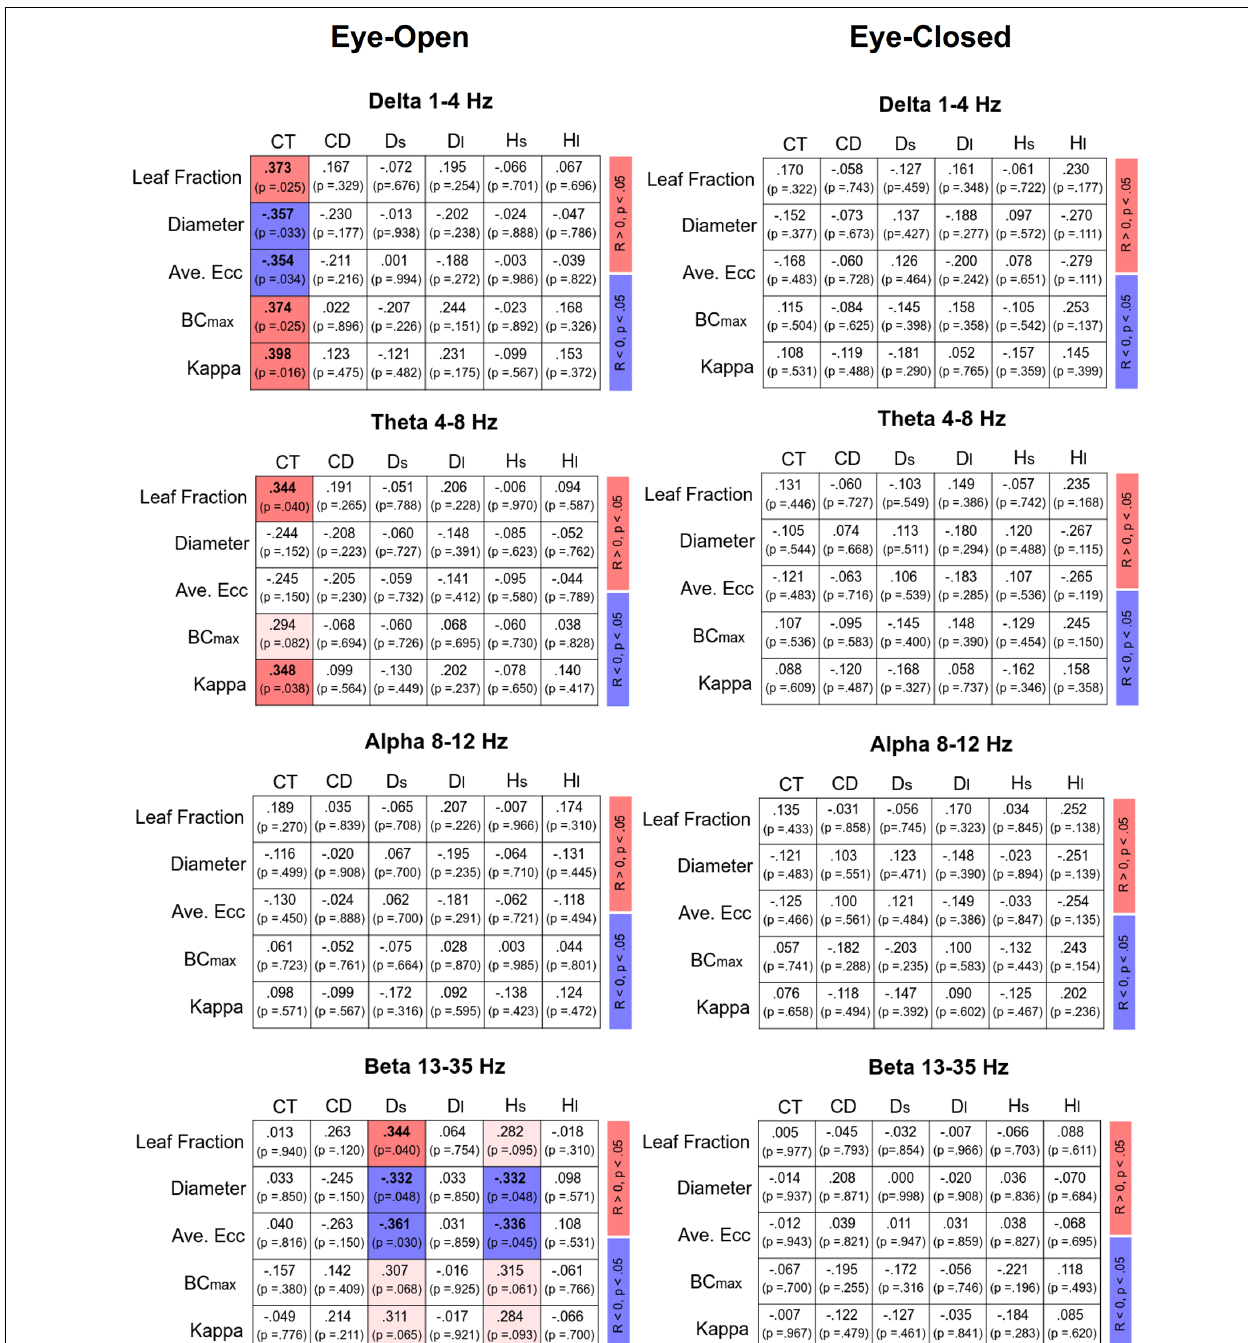
FIGURE 4 | Correlation matrix of sub-band MST and SDA variables and corresponding significance levels for the eyes-open (EO) and eyes-closed (EC) conditions. Red and blue shaded areas represent significant positive and negative correlations ( p < 0.05) of the sub-band MST and SDA variables, respectively. Light shaded areas represent marginally significant correlation of the sub-band MST and SDA variables ( p <